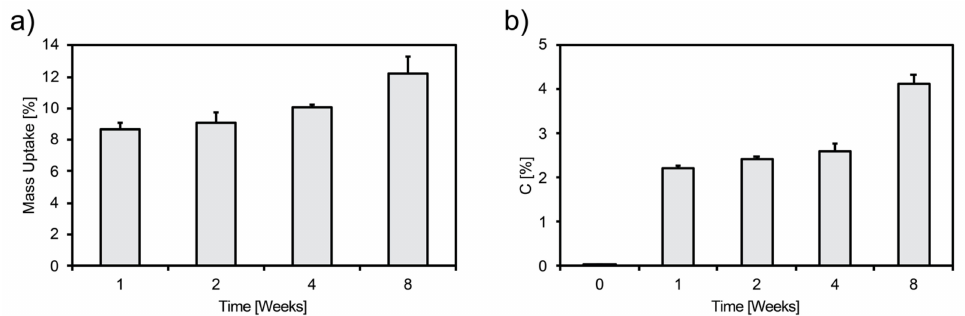
Figure 1. ( a ) Mass and ( b ) carbon uptake vs. aging time.